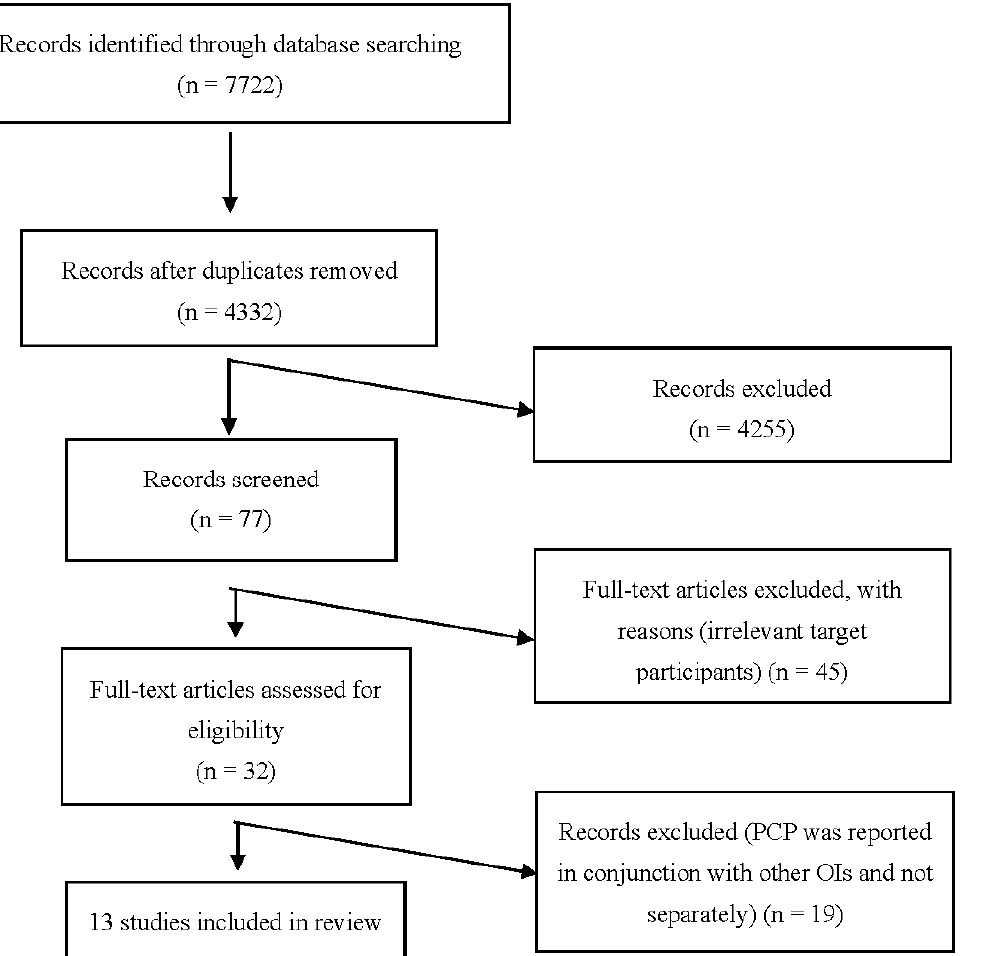
Figure 1. PRISMA flow diagram of identification and selection of studies for the systematic review and meta-analysis. PCP: Pneumocystis pneumonia. OIs: opportunistic infections.